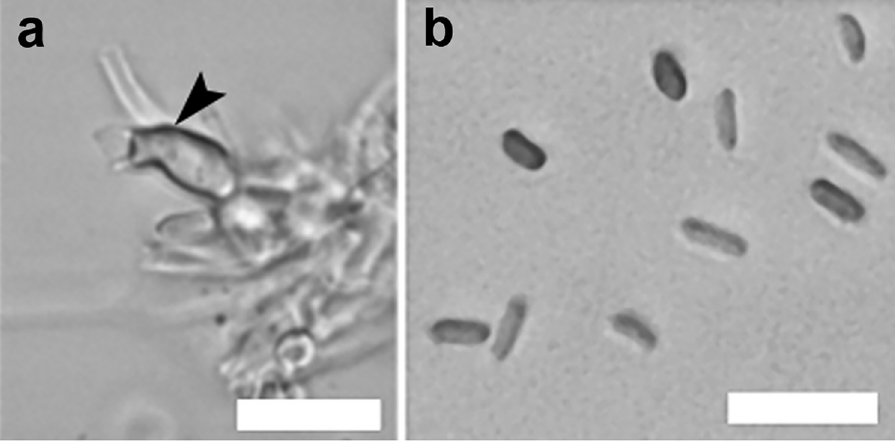
Fig 3. Reproductive cells of the K . longispora isolate T15142. Sporulation was induced on pine needles placed on PDA medium. ( a ) Conidiogenous cell (arrowhead); ( b ) conidia. Scale bars = 10 μ m.